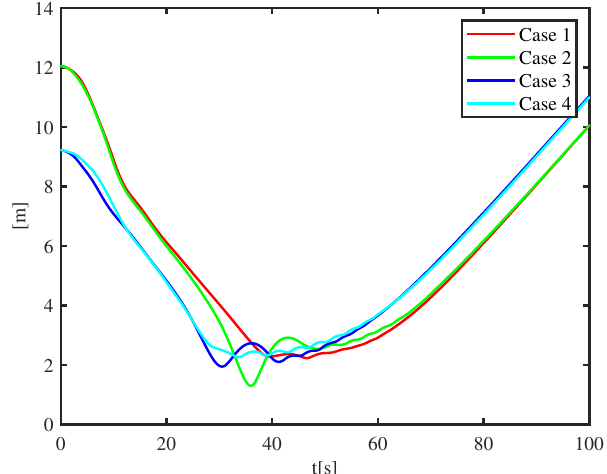
Figure 2. Trajectory tracking control under four cases (the blue circle denotes obstacle).